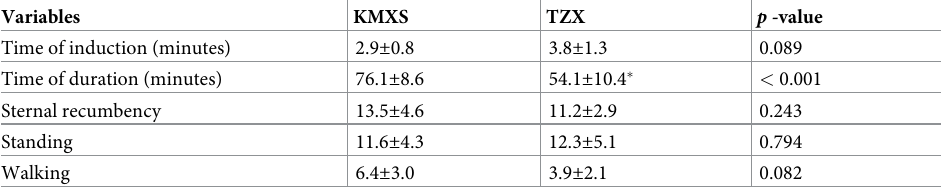
Table 2. The times of induction, duration, the times to onset of sternal recumbency, standing and walking in pigs that were treatment with ketamine-midazolam-xylazine-sufentanil (group KMXS) or tiletamine-zolazepam-xyla- zine (group TZX) in phase